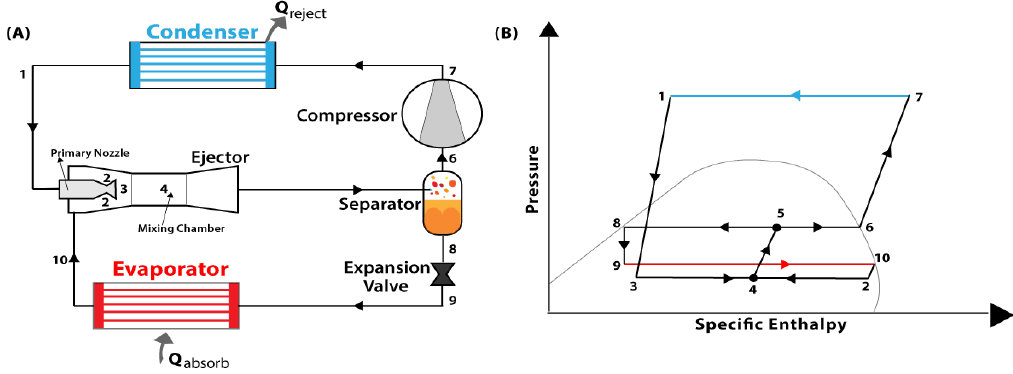
Figure 1. ( A ): Illustration of schematic of Ejector expansion refrigeration cycle (EERC); ( B ): Shows corresponding pressure enthalpy (P-h) diagram for EERC cycle.